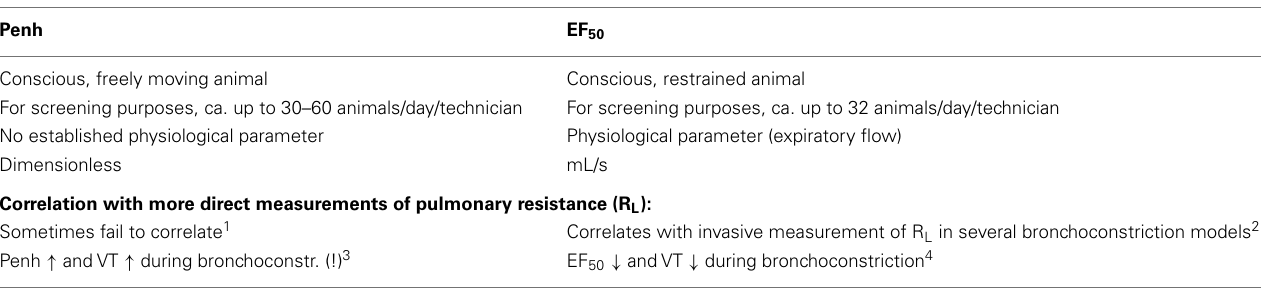
Table 3 | Short comparison of Penh with tidal midexpiratory flow (EF 50